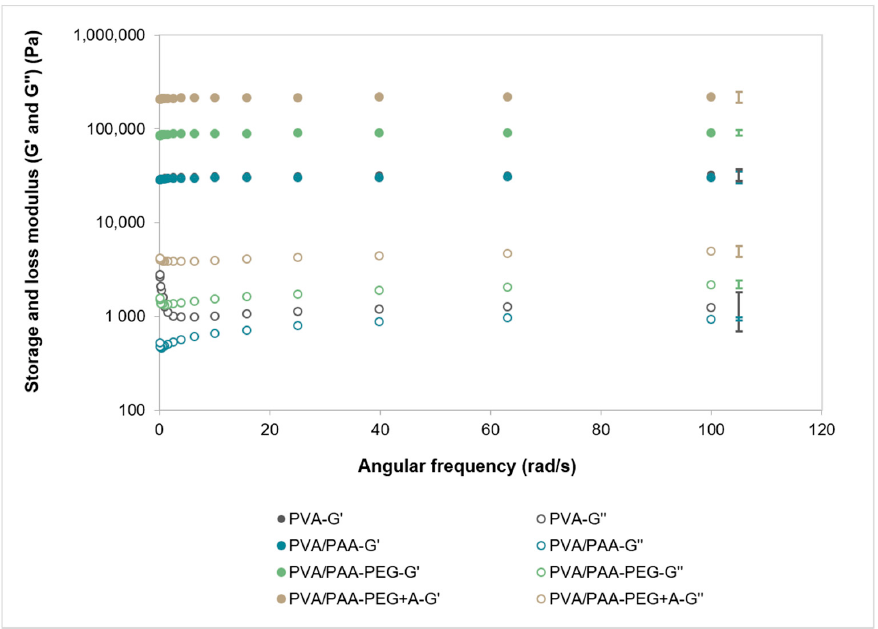
Figure 5. Variation of the storage modulus (G’) and loss modulus (G’’) during an angular frequency sweep for all studied hydrogels. Error bars are the ± standard deviations, n = 4.